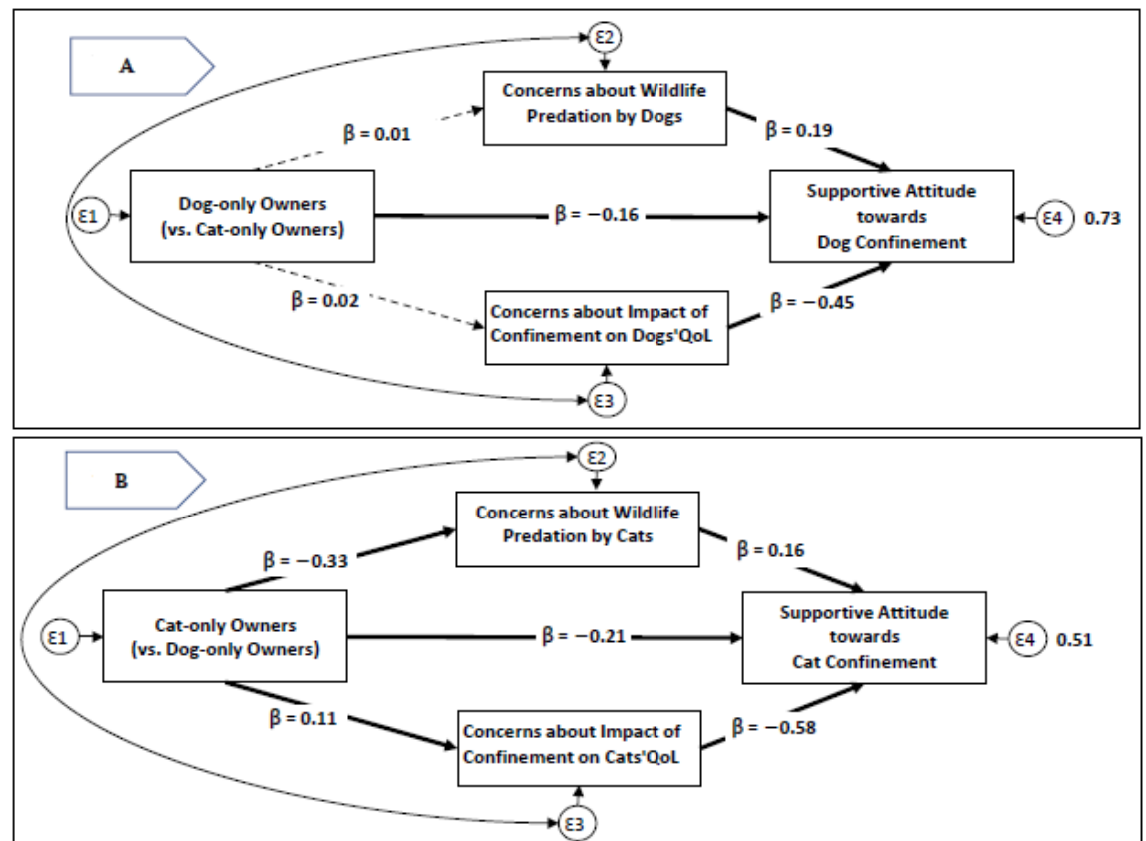
Figure 4. Path analysis for the relationships between pet ownership and attitudes towards pet confinement for dogs ( A ) and cats ( B ), testing mediating effects of Concerns about impacts of confinement on pet’s QoL and Concerns about wildlife predation by pets; values are standardized regression coefficients (Beta); solid arrows represent statistically significant associations ( p < 0.05). Dashed arrows indicate non-significant associations ( p > 0.05).